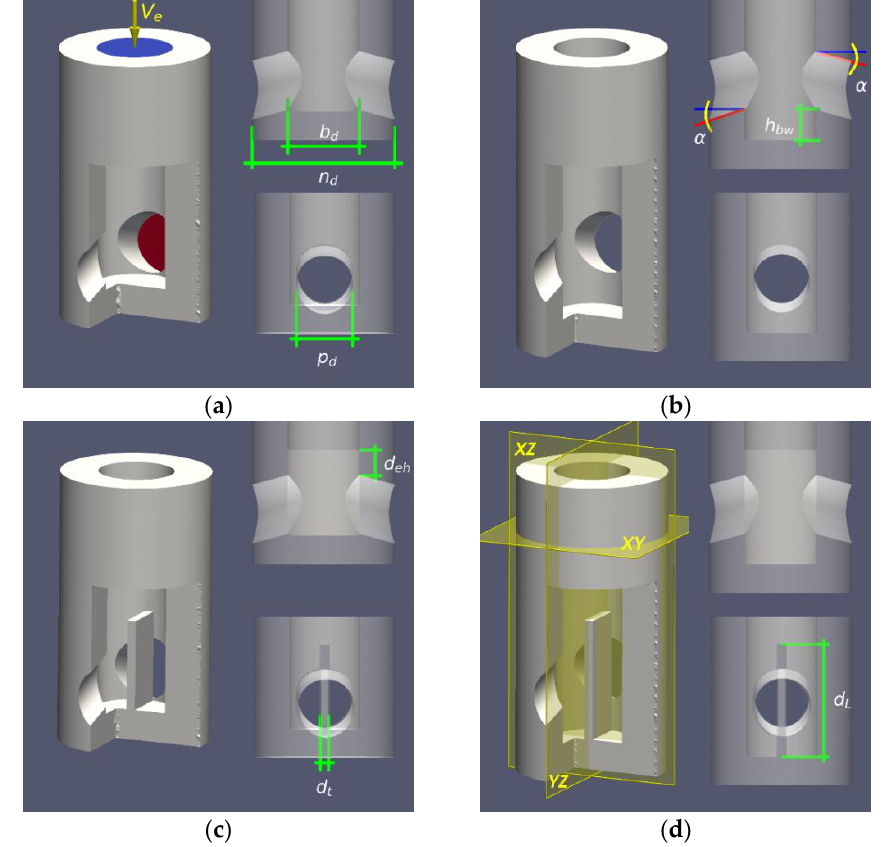
Figure 4 . Dimensions and geometric characteristics of the nozzles studied in this work. ( a ) FB-nozzle. ( b ) WB-nozzle. ( c ) FBFD-nozzle. ( d ) WBFD-nozzle.